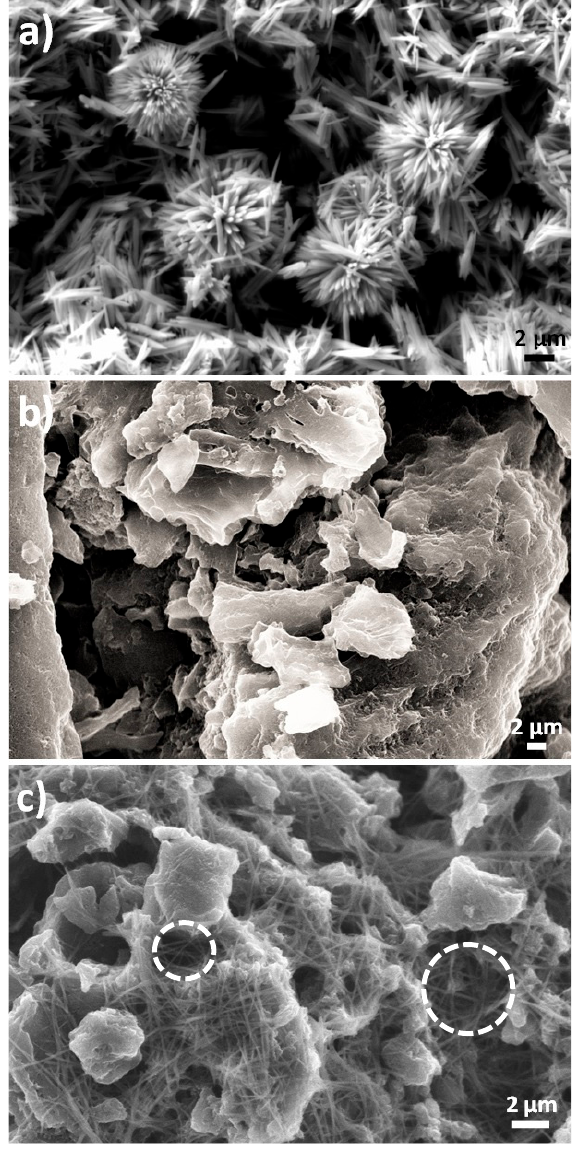
Figure 1. SEM images of ( a ) ZnO nanostructures, ( b ) AC, and ( c ) AC/ZnO composite.